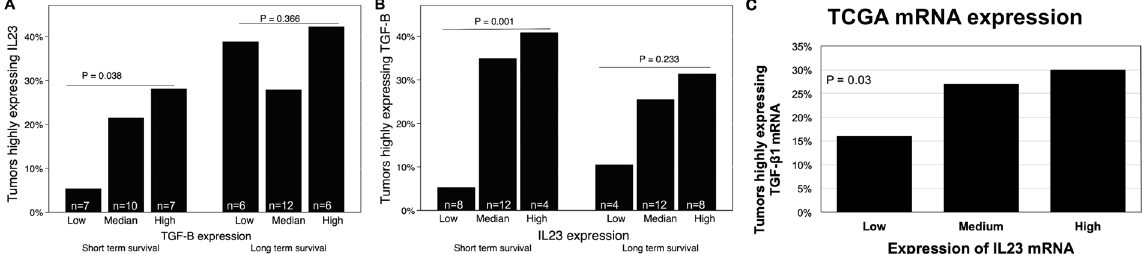
Figure 2. Relationship between IL23 and TGF-ß protein expression in patient tumor specimens. For short- term survivors, IL23 tumor expression is linearly correlated with TGF-ß tumor expression (P < 0.05, left side of A , B ) whereas IL23 expression is not correlated with TGF-ß expression in long-term survivors (P > 0.2, right side, A and B ). Data from the TCGA demonstrated correlation between IL23 and TGF-ß1 gene expression in those PDAC tumor specimens (P = 0.03, C ).